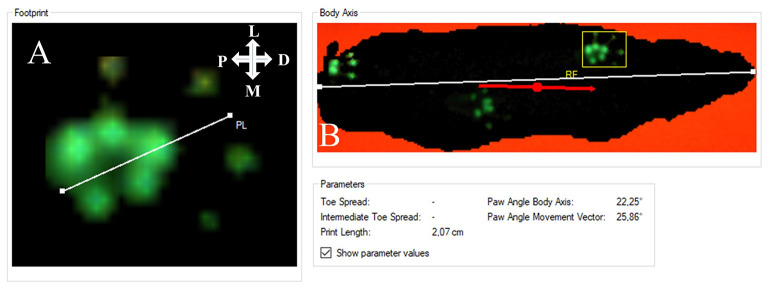
Evaluation of the degree of external paw rotation by measuring the Paw Angle Body Axis. This is the angle between the orientation of the front paw (A) and the animal's body axis (B). Note that both axes can be individually drawn by the experimenter analyzing the CatWalk (CW) data. (A) The white line defines the orientation of the paw. (B) The white line defines the animal's body axis. The red line defines the animal's body movement vector, which is calculated by linear regression of the animal's center of gravity in the recorded frame and in the three frames preceding it. The white cross indicates the orientation of the respective paw in relation to the rat's body axis; P, proximal; D, distal; M, medial; L, lateral.